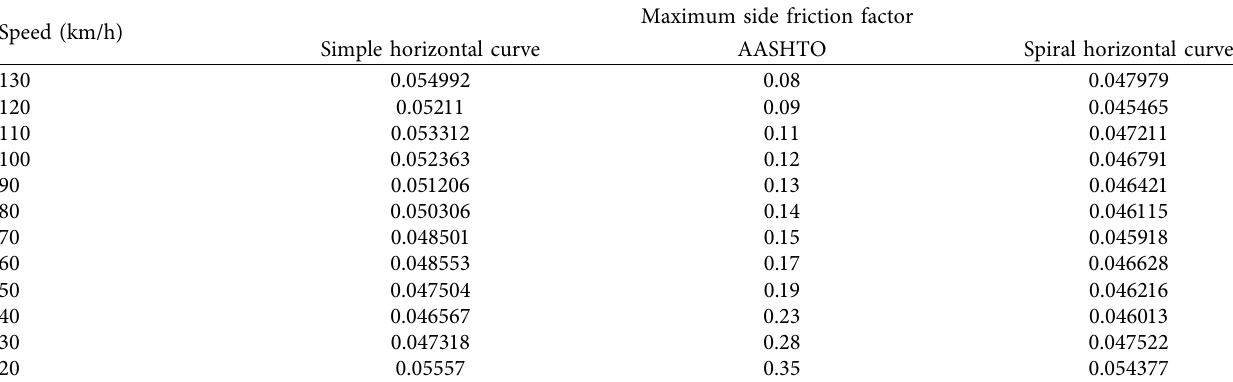
Table 12: Comparison of the maximum side friction factor between simple and spiral horizontal curves and AASHTO recommended values for sedan at a radius of